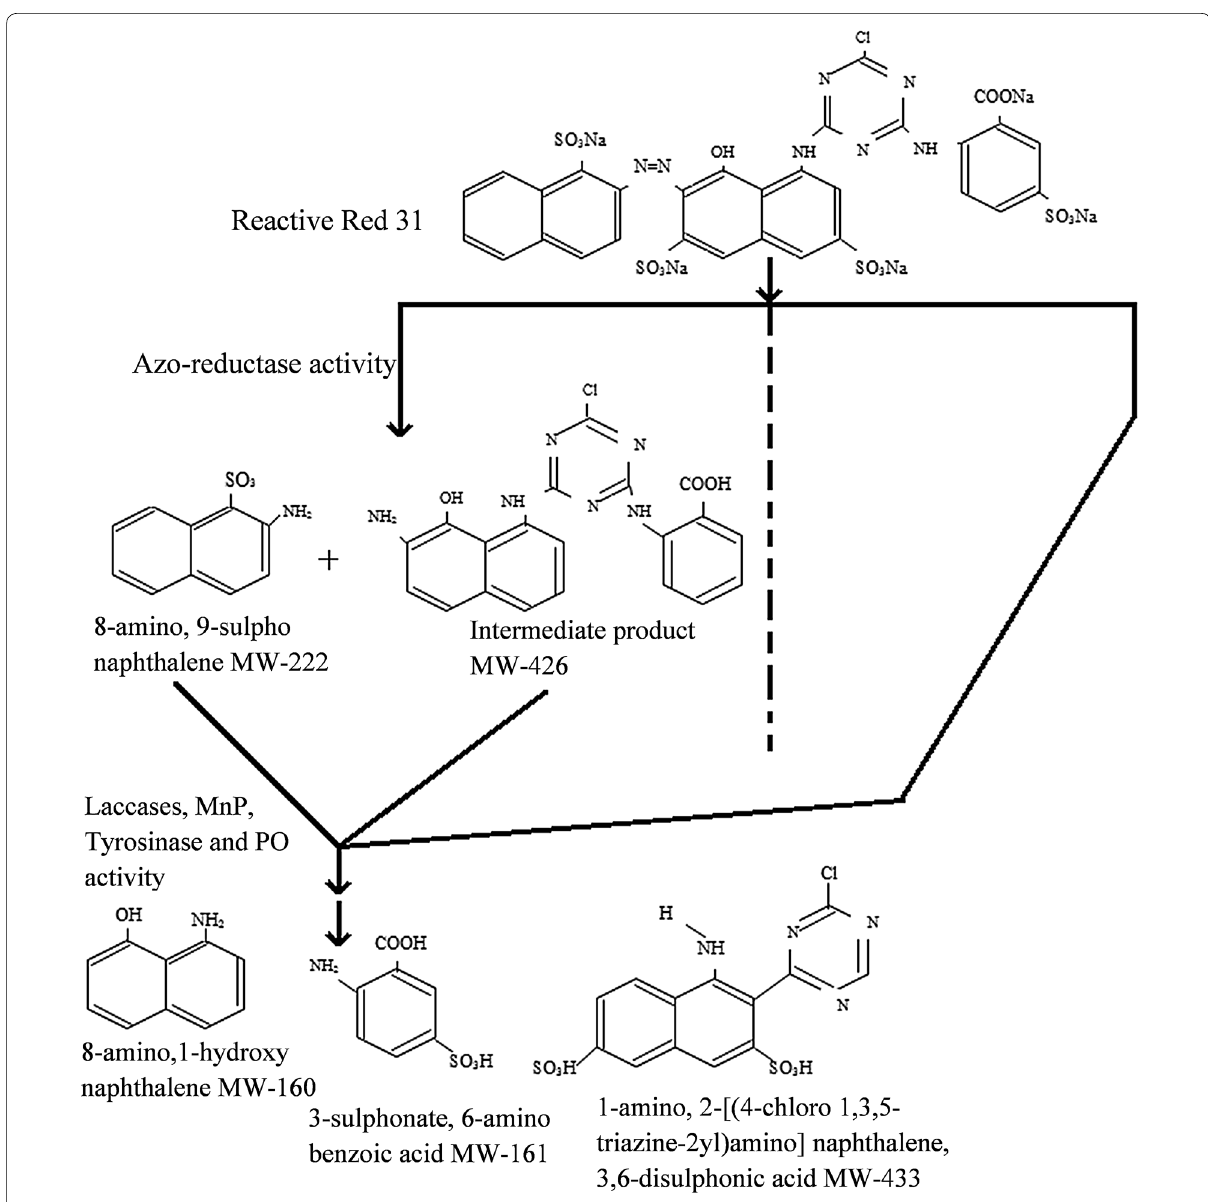
Fig. 7 Proposed biodegradation pathway of Reactive Red 31 by Aspergillus bombycis